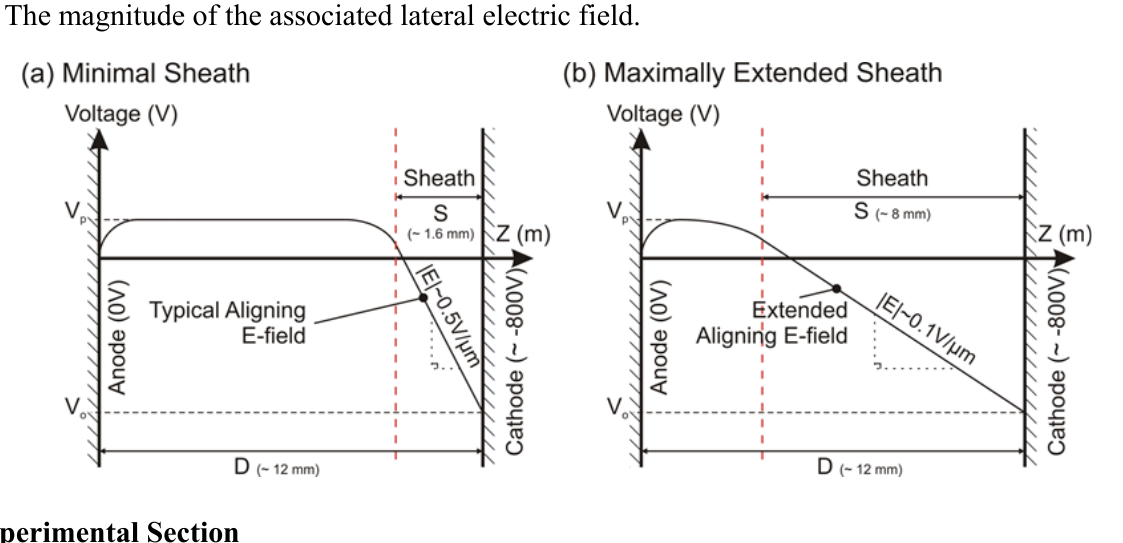
O /Fe sample grown in the horizontal 2 x